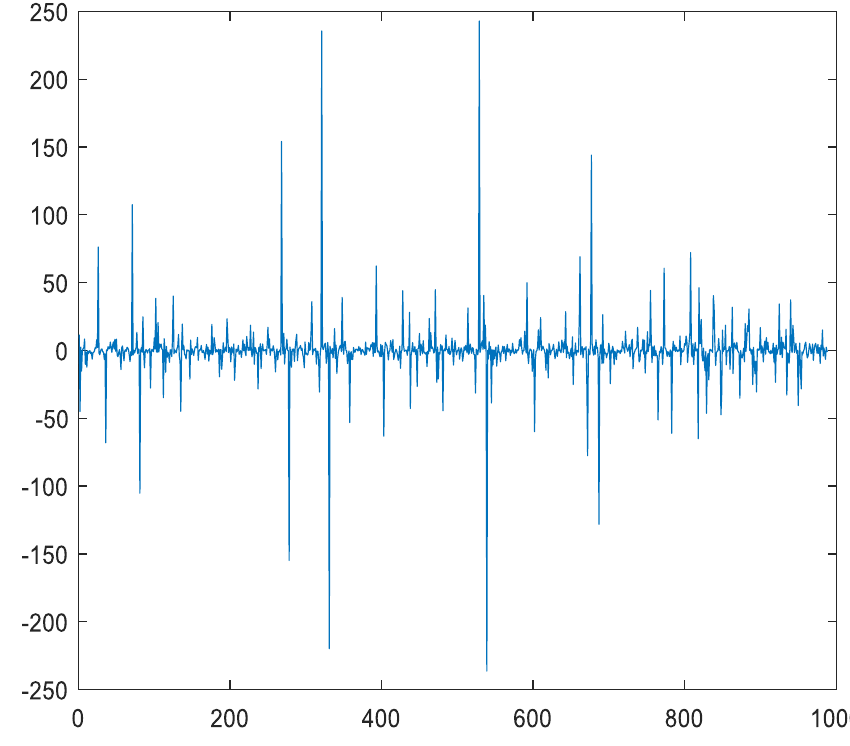
Figure 4. GP increment time series.